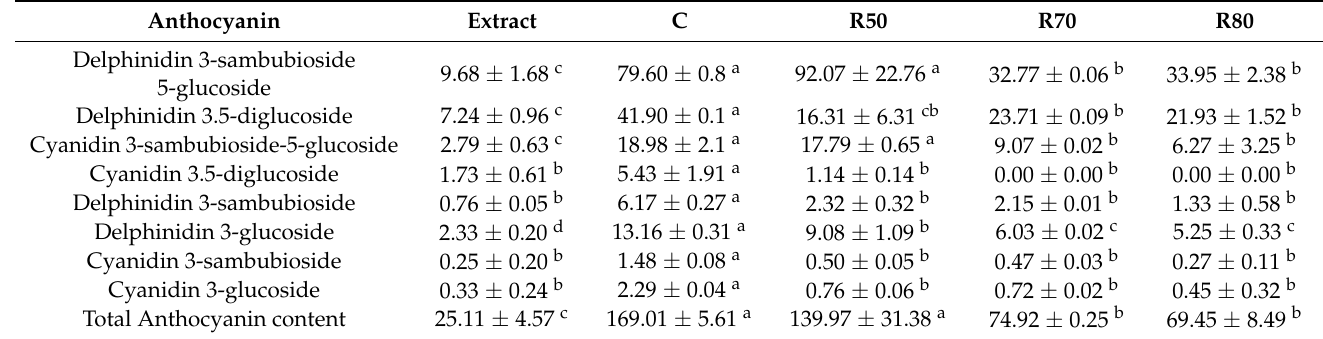
Table 2. Anthocyanin content (mg cyanidin 3-glucoside/g) of maqui ( Aristotelia chilensis (Mol.) Stuntz) extract, cryoconcentrate, and concentrates by evaporation at 50, 70, and 80 ◦